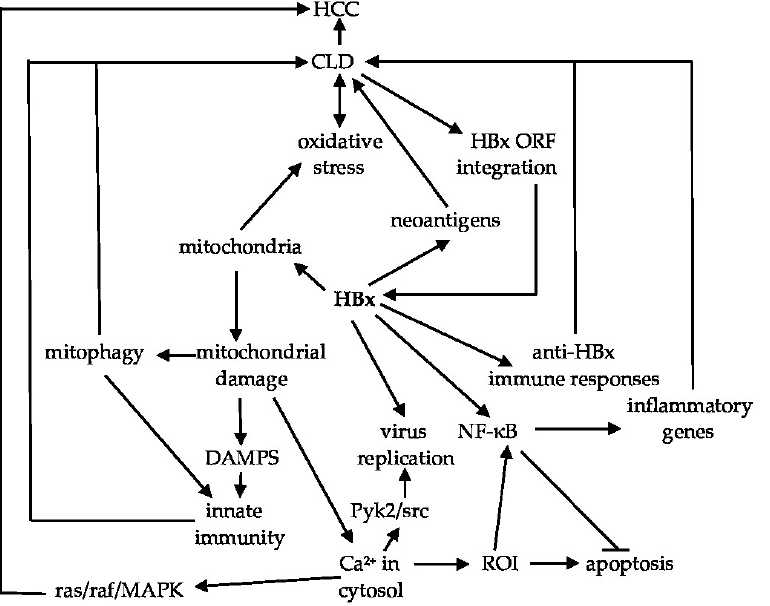
Figure 3. Selected mechanisms whereby HBx contributes to CLD. This includes association of HBx with mitochondria, resulting in mitochondrial damage, mitophagy, and the stimulation of innate immunity through activation of mitochondria-associated MAVS/RIG1. HBx also stimulates virus gene expression and replication [6,74], and promotes systemic inflammation and oxidative stress in the infected cell (which stimulates HBx activity), but at the same time protects hepatocytes from immune-mediated damage via constitutive activation of NF- κ B. Hepatocellular regeneration associated with CLD provides opportunities for HBx–ORF integration events, which results in the accumulation of intrahepatic HBx and progression of CLD to HCC. Abbreviations: Ca 2+ —calcium ions, CLD—chronic liver disease, DAMPS— damage-associated molecular patterns, HBx—hepatitis B x antigen, HCC—hepatocellular carcinoma, nuclear factor kappa B, ORF—open reading frame, Pyk2—proline-rich tyrosine kinase 2, RIG1—retinoic acid-inducible gene I, ROI—reactive oxygen